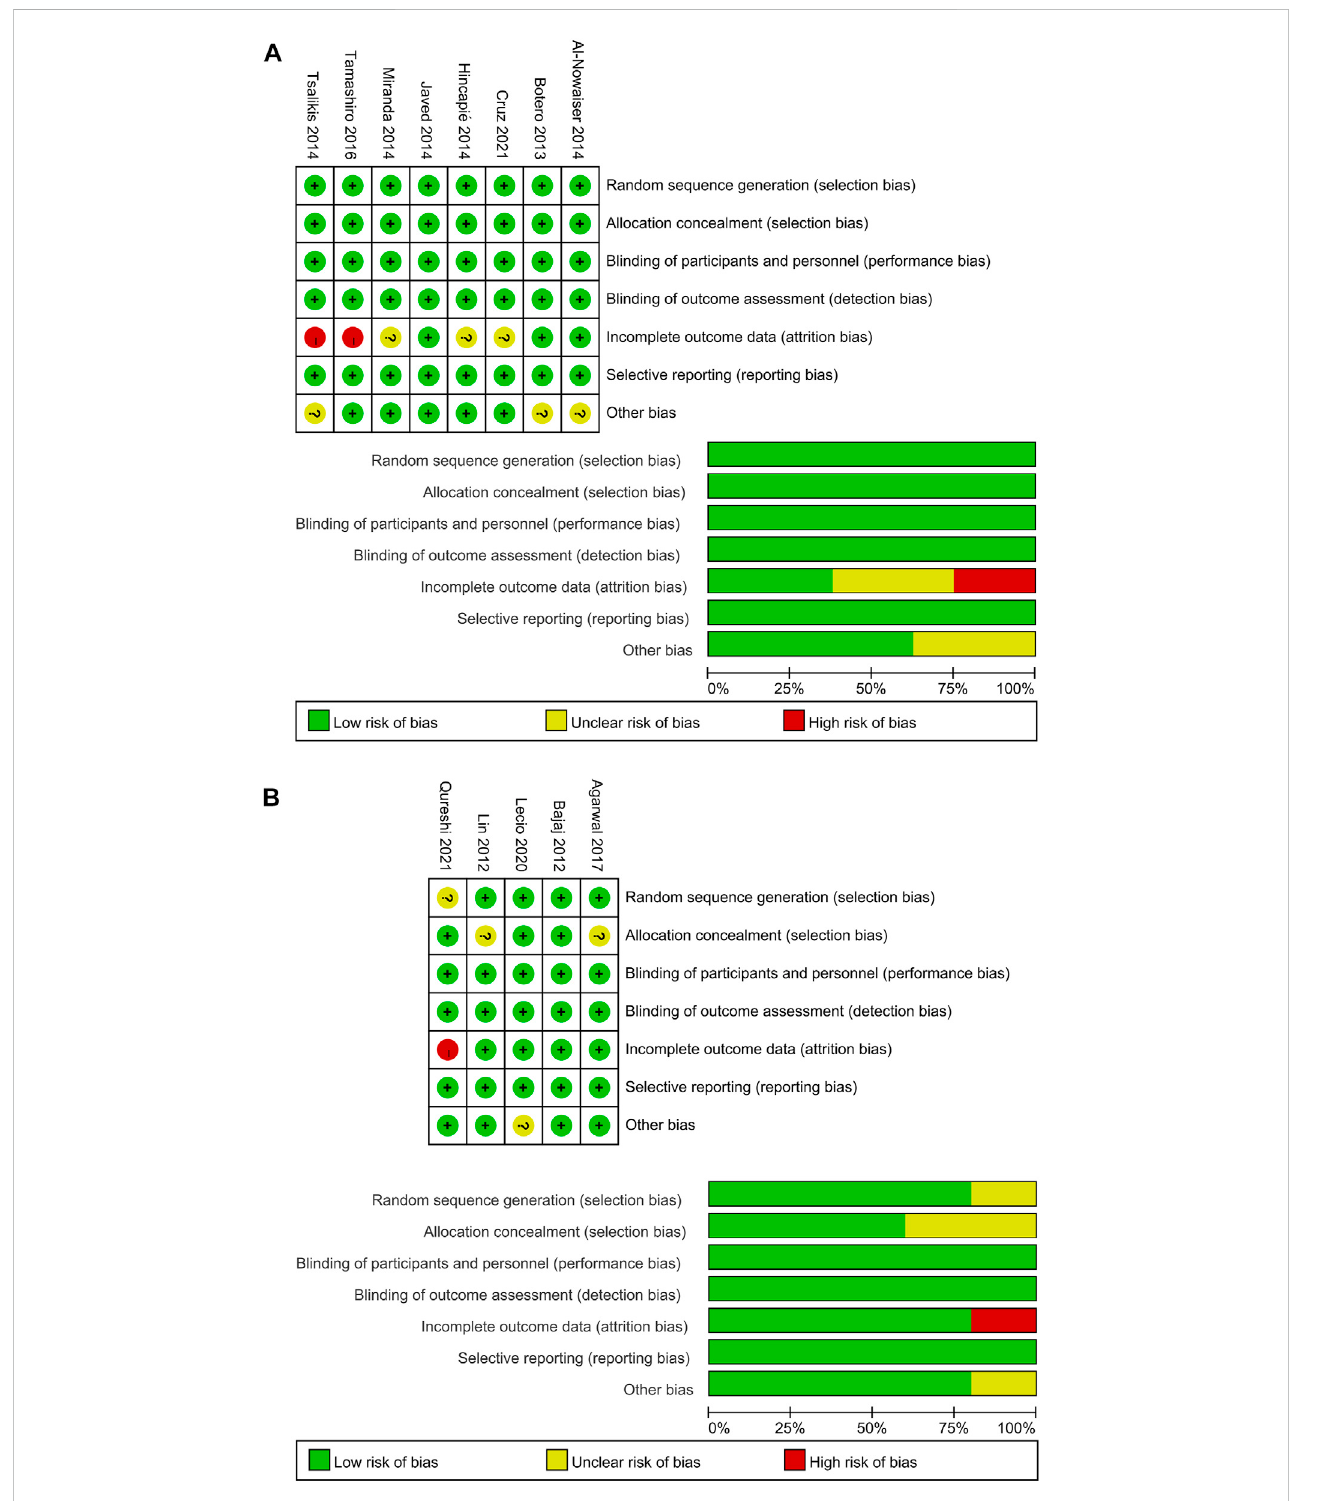
FIGURE 2 Quality assessment of the included studies using the Cochrane Collaboration tool for assessing risk of bias. (A) Systemic antibiotics. (B) Topical